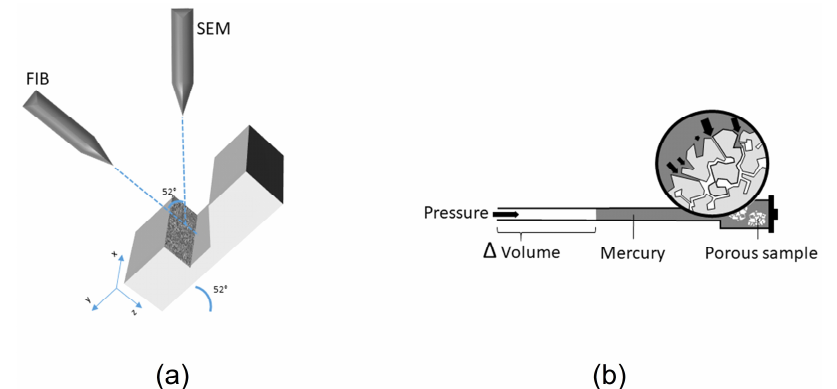
Figure 1. A schematic representation of focused ion beam scanning electron microscopy (FIB-SEM) and mercury intrusion porosimetry (MIP). ( a ) For FIB-SEM, a sample is tilted to be perpendicular to the ion (gallium) beam. The ion beam then mills a trench in the z direction of the sample, revealing a cross section, which is then imaged by the electron beam. ( b ) In an MIP setting, the pressure applied to the penetrometer pushes a non-wetting liquid (mercury) inside the pores of the sample. Pore size is calculated based on the pressure needed to force mercury into